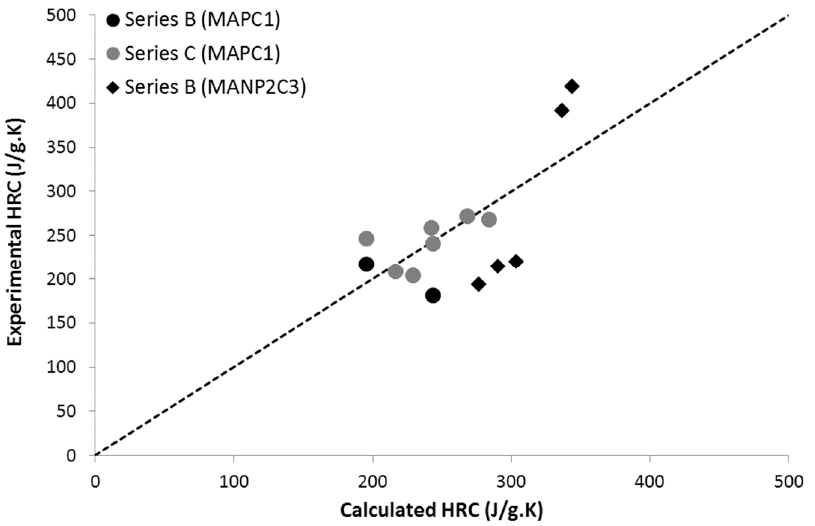
Figure 8. Experimental versus calculated HRC for polymers containing PO 3 pendant groups from series B and C (i.e., methacrylate co-polymers including MAPC1 or MANC2P3 monomers).